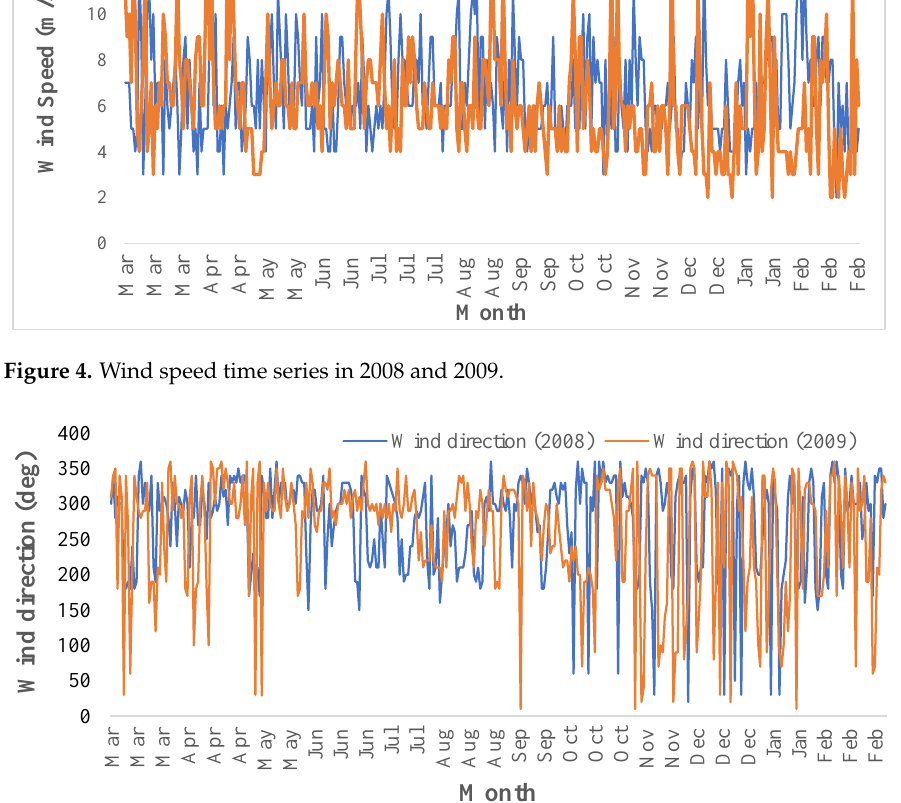
Figure 5. Wind direction series in 2008 and 2009.